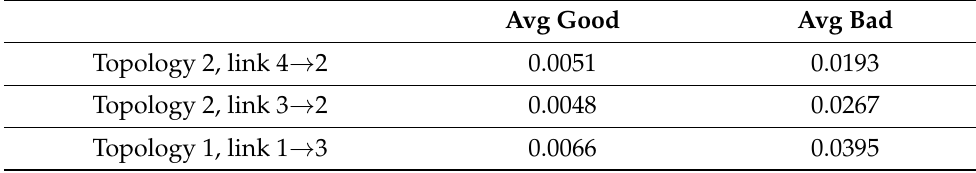
Table 3. Average BER values, two-state